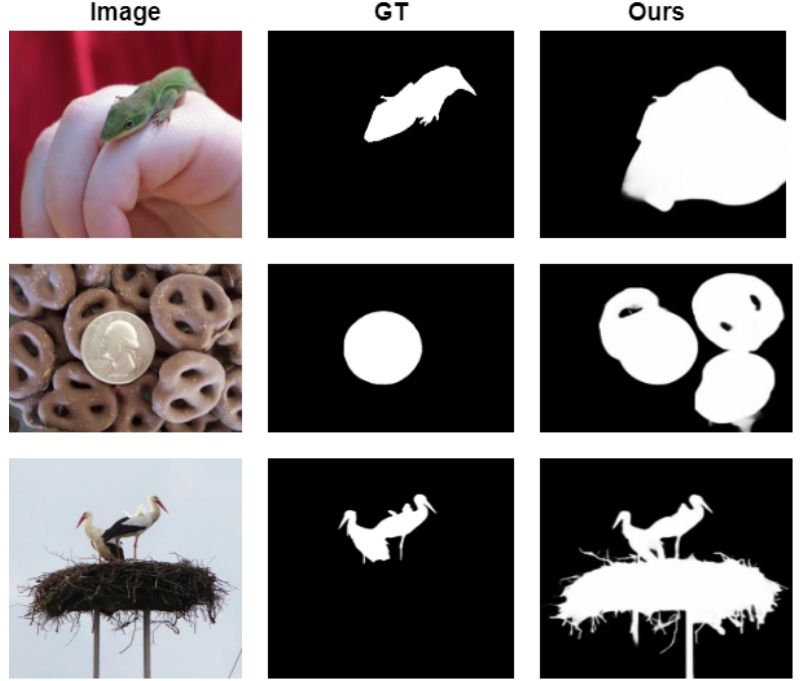
Figure 5. Illustration of misclassification of the salient class in an image by the proposed